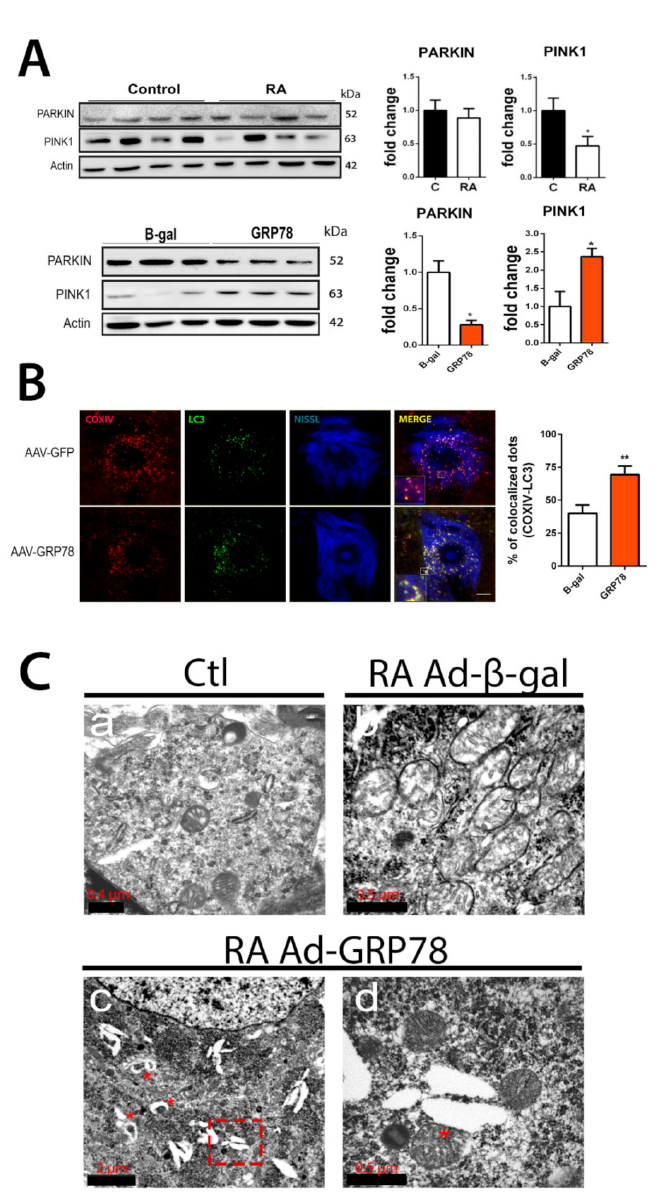
Figure 2. Mitophagy is modulated in vivo after RA in rats that overexpress GRP78. ( A ) Im- munoblots and corresponding bar graphs for PINK1 and PARK fold change analysis of protein levels (means ± SEM) normalized to actin levels, in the L4-L5 spinal cord segments of RA-injured rats vs. control (top) or from Ad- β -Gal and Ad-GRP78 groups (bottom) by 7 dpi. ( n = 4; * p < 0.05, Student’s t -test). ( B ) Left, microphotographs of representative MNs at the ipsilateral site from RA- injured animals that received an intrathecal injection of AAVrh10-GFP or AAVrh10-GRP78 groups at 7 dpi. Samples were stained for COX IV (red) and LC3 (green) and counterstained with fluorescent Nissl (blue). Scale bar = 10 µ m and digital zoom in insets 10X. Note that co-localization is only observed in the AAVrh10-GRP78 group. Right, bar graph showing the analysis of % of co-localization dots of COX IV and LC3. Average ± SEM of COX IV and LC3 co-localization ( n = 4; ** p < 0.01, Student’s t -test). ( C ) Representative transmission electron microscopy images where mitochondria are distinguished within MNs of spinal cords: a, image of MN cytoplasm showing mitochondria in control animal; b, image of MN cytoplasm from RA-injured rat from the Ad- β -gal group; c, image of MN cytoplasm from RA-injured rat from the Ad-GRP78 group with some engulfed mitochondria indicated with red asterisks; d, higher magnification image is shown in ( C ) pointing out a large mitochondria and ER contact. Scale bars are indicated in the